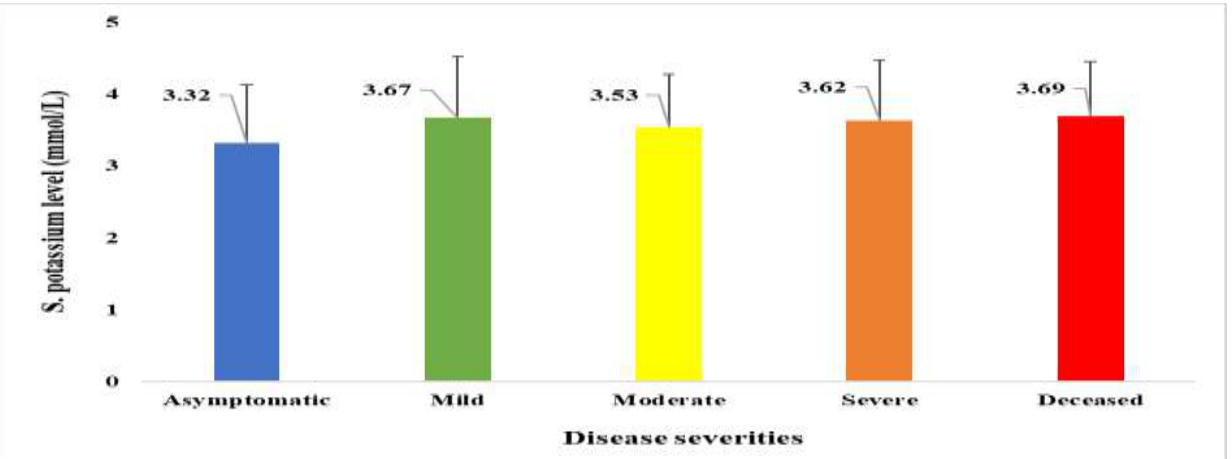
Figure 10: Potassium levels in 100 patients with COVID-19 revealed in different disease